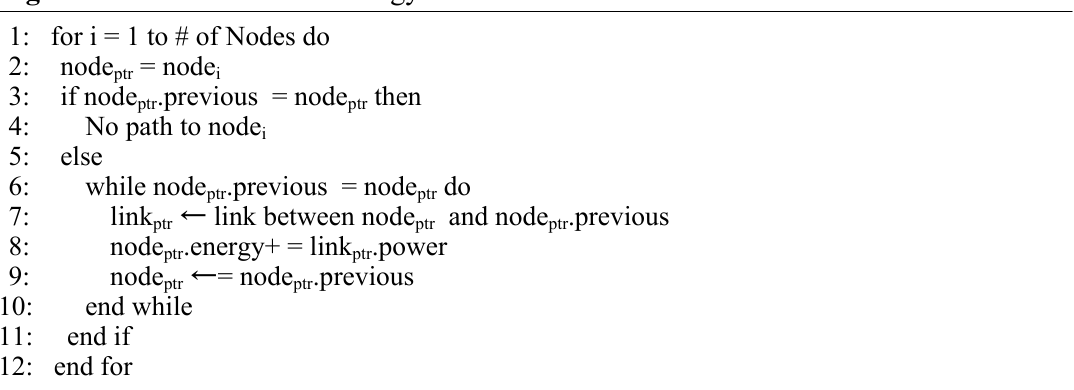
Algorithm 2. Accumulated Energy